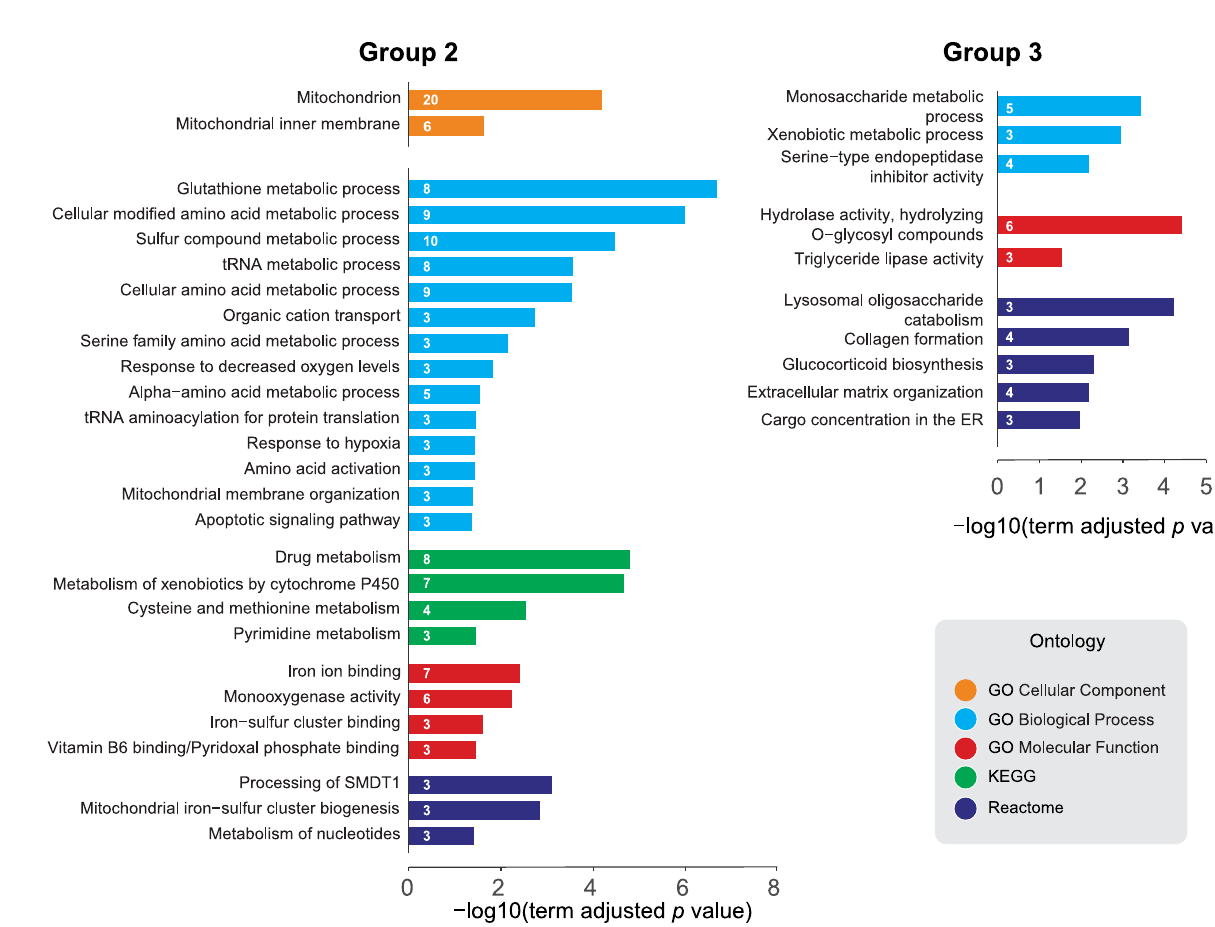
Figure 7. ClueGO pathway enrichment analysis (PEA) of dPerk-dependent targets. Genes that were upregulated at the transcript level but not at the protein level (group 2, left ) and genes that were downregulated at the transcript and protein level (group 3, right ) were analysed. PEA was performed using ClueGO, a Cytoscape application. Selected results from the Gene Ontology (GO) Cellular Component, GO Biological Process, GO Molecular Function, KEGG and Reactome, ontology terms and their -log10 (adjusted term p -value) are shown. The number of targets of a specific functional term is displayed on the